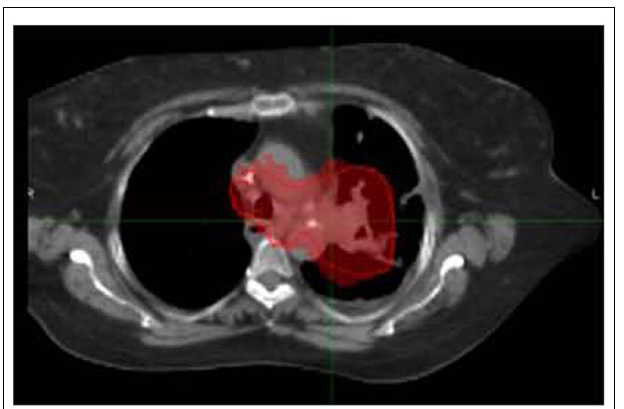
FIGURE 2 |The same patient in Figure 1A was treated with concurrent chemoradiation with a total dose of 66 Gy in 2 Gy fractions.